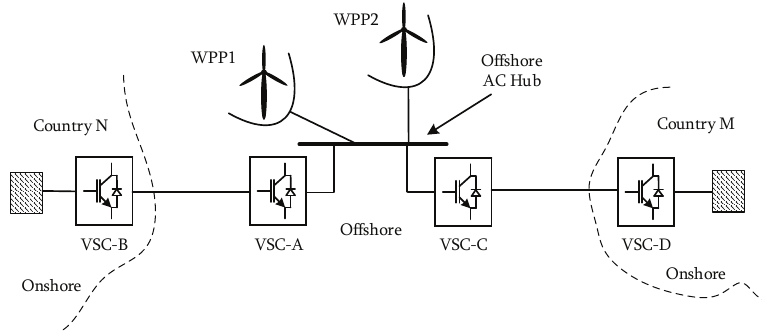
Figure 1. Network configuration to transfer offshore wind energy to different countries using